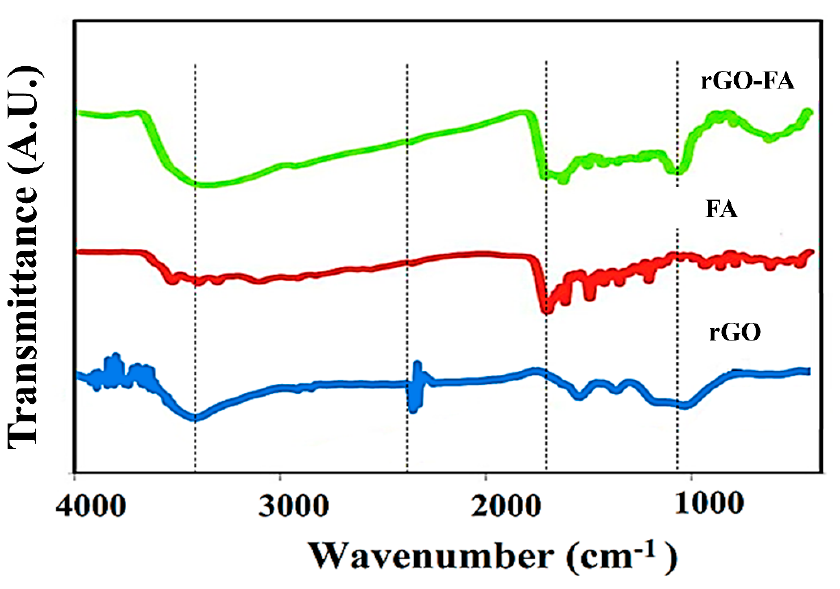
Figure 2. FTIR spectroscopic analysis of dried forms of rGO, FA, and rGO-FA using spectroscopic grade KBr-based pellets.